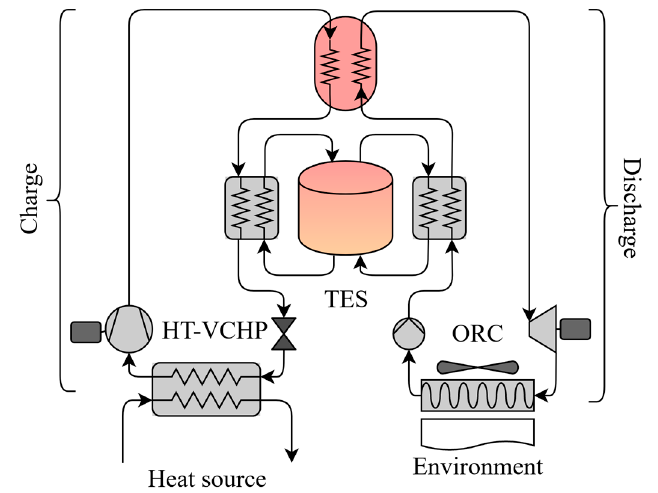
Figure 7. TI-PTES configuration (CHEST) investigated in [6,51,52,54,59].